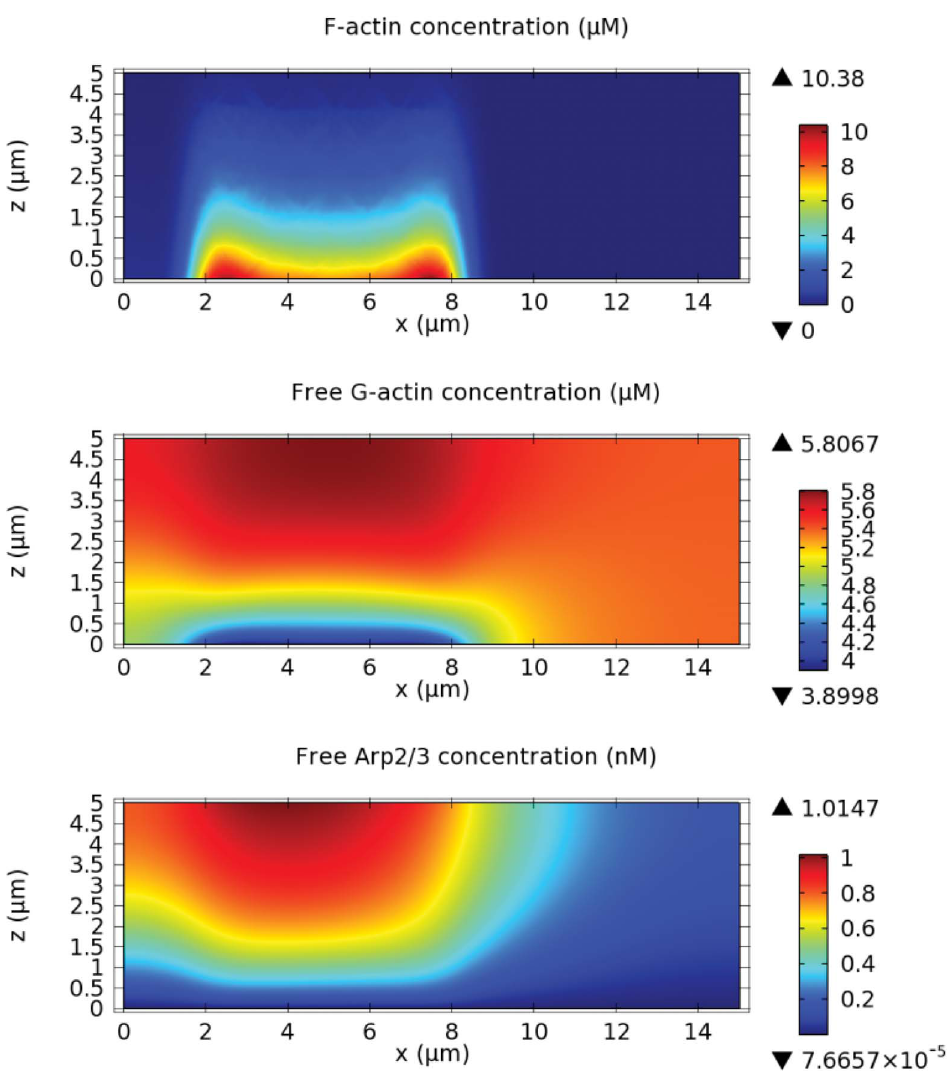
Figure 10. Actin waves at higher Arp2/3 concentration. The distributions of free Arp2/3 (bottom) and G-actin (middle) from a simulation on a 15 m m | 5 m m domain with 100 nM initial Arp2/3 concentration are depicted with the corresponding F-actin density (top) . Membrane diffusion of WASP and its complexes is incorporated in the simulation. D mem ~ 0 : 4 m m 2 = s , k C ~ 40 m M { 1 s { 1 , k U ~ 7 : 4 | 10 { 2 m M { 1 nm { 1 s { 1 ,